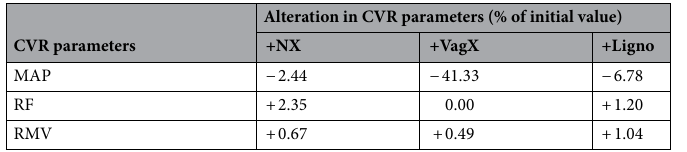
Table 3. Alteration in cardiorespiratory (CVR) parameters with 10 mM histamine after ipsilateral somatic neurotomy (+NX), bilateral vagotomy (+VagX) and pre-treatment with lignocaine (+Ligno). MAP mean arterial pressure, RF respiratory frequency, RMV Respiratory minute volume. + NX, + VagX and + Ligno attenuate MAP, RF and RMV parameters significantly [ P < 0.05, two sided Dunnett’s test] as compared with the histamine (10 mM) only group [Table 1]. + / − indicates increase/decrease